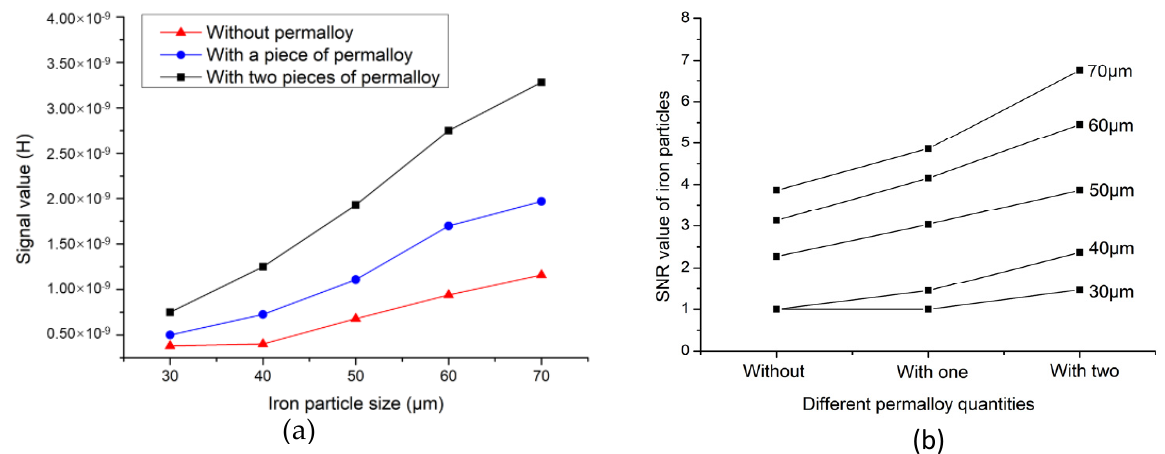
Figure 11. Iron particle detection results: ( a ) Average signal value of iron particles; ( b ) Average SNR value of iron particles.